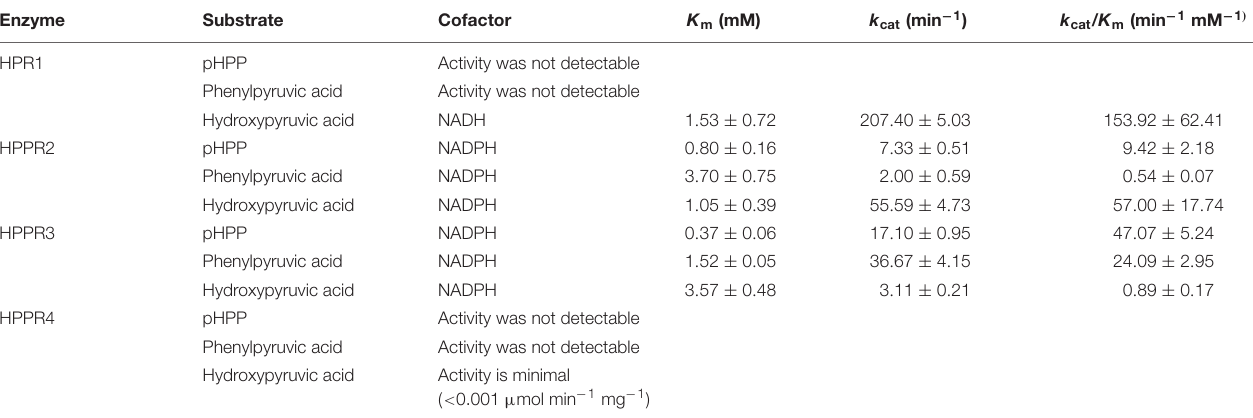
TABLE 1 | Kinetic parameters of HPR1 and